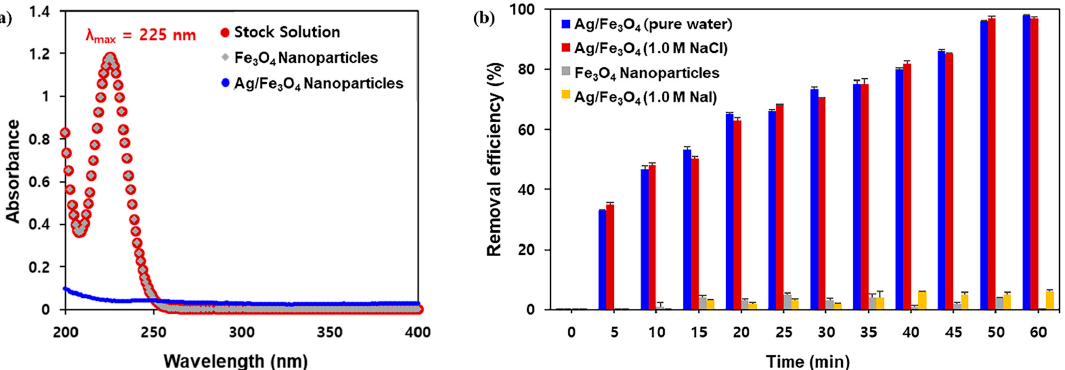
Figure 4. ( a ) UV absorption spectra of iodine after treatment with Fe 3 O 4 or Ag/Fe 3 O 4 composite nanoparticles in water; ( b ) removal efficiency of Ag/Fe 3 O 4 nanocomposites at high salt concentrations, and the control study using Fe 3 O 4 nanoparticles.